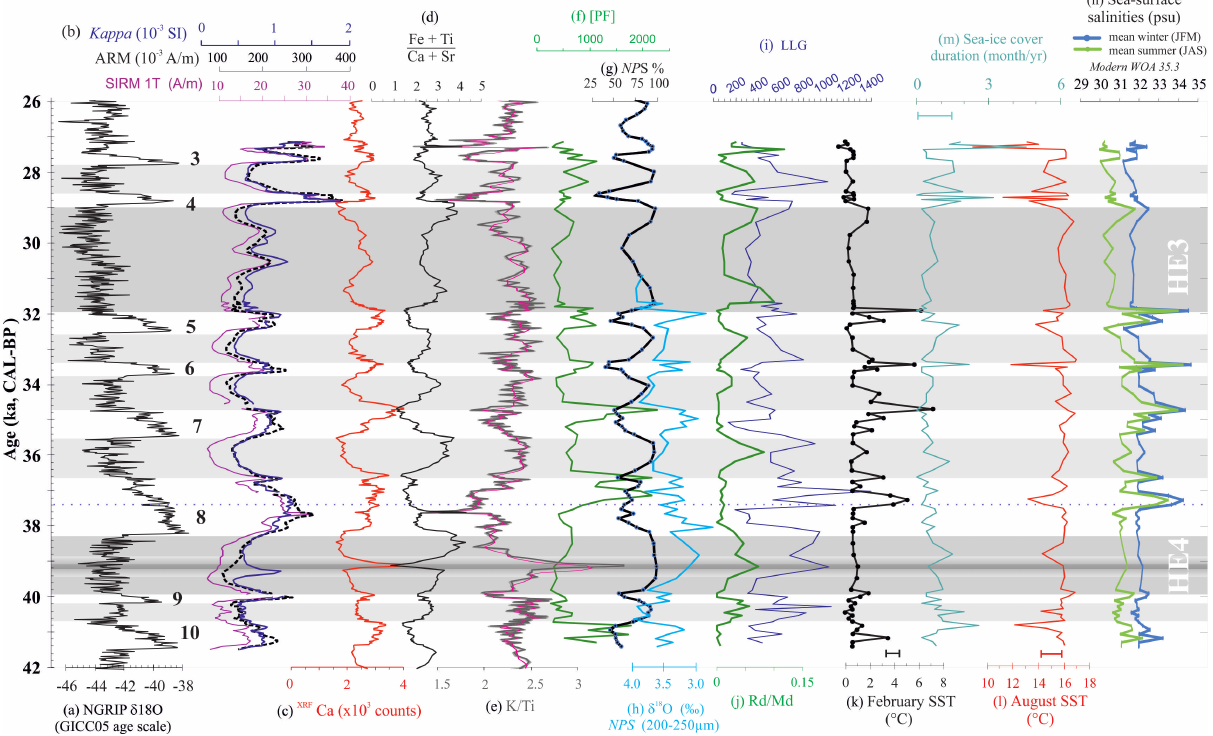
Fig. 6. Multiproxy results obtained on the MIS3 section of core MD99-2281 compared to the (a) δ 18 O NGRIP GICC05 record (Svensson et al., 2008), with: (b) Magnetic properties (volume susceptibility – Kappa – ARM; Isothermal Remanent – IRM – magnetizations); XRF data with (c) Ca raw counts, (d) ratio (Fe+Ti)/(Ca+Sr) and (e) ratio K/Ti (pink curve: smoothed 3 points running average); (f) planktonic foraminifera absolute concentration in the sediment ([PF]=Nb. of shells > 150µm per g of dry sed.); (g) relative abundances (%) of the polar taxon N. pachyderma sin. (NPS); (h) δ 18 O measurements on monospecific samples of NPS shells (200–250µm); (i) Large lithic grain concentration in the sediment (LLG=Nb. of grain > 150µm per g of dry sed.); (j) Reworked dinocyst versus modern dinocyst concentrations, i.e. Rd/Md ratio; (k) – (n) dinocyst derived reconstructions of sea-surface conditions with (k) February SST ± 1.1 ◦ C; (l) August SST ± 1.6 ◦ C; (m) sea-ice cover duration ± 1.1 months per year, (n) sea-surface salinities ± 2.5psu. Greenland stadials (light grey bands), including Heinrich events (dark grey bands) are defined in agreement with the stratigraphic synthesis of Wolff et al. (2010). Within HE4, the 39ka event (see text) is